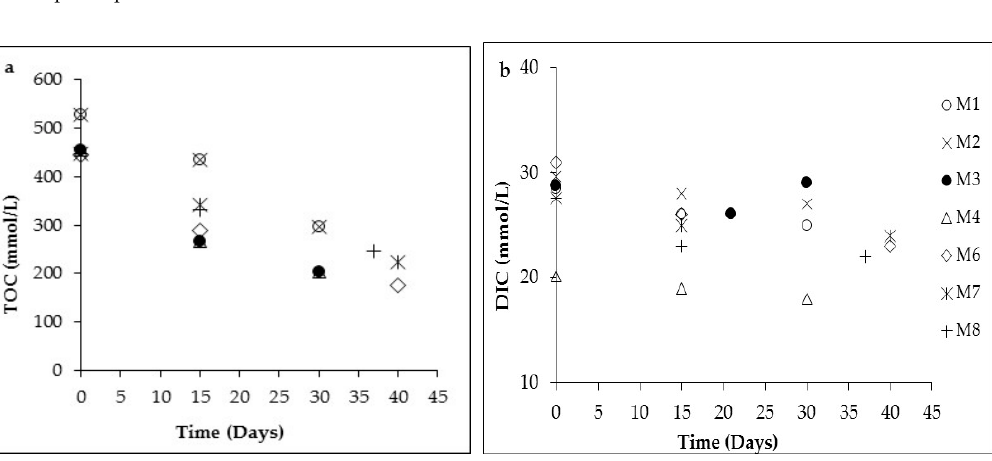
Table 3. Mineralogy of the bioliths derived from XRD analysis.